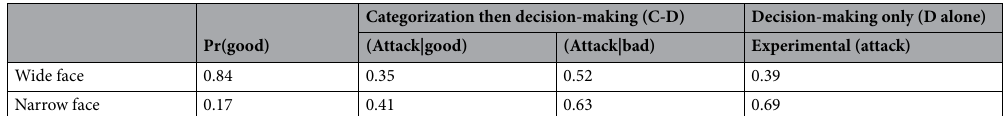
Table 5. The probability of taking defensive action under two different situations of the C-D condition and the D-alone condition 12,68 .